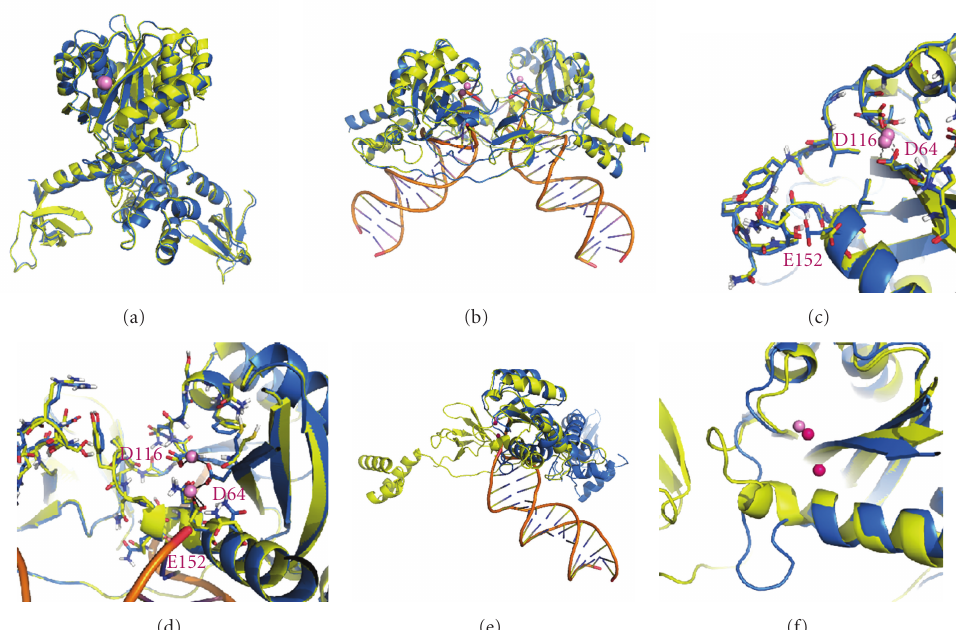
Figure 1: Structural models of the HIV-1 INs from B and CRF02 AG strains. (a) Superimposition of models 1 and 2, representing the enzyme before the 3 (cid:2) processing from B (in blue) and CRF02 AG (in yellow) strains; (b) Superimposition of models 3 and 4, representing the IN · DNA pre-integration complex from B (in blue) and CRF02 AG (in yellow) strains; (c) and (d) Comparison of the catalytic site and loop 140–149 structure in models 1/3 (in blue) and 2/4 (in yellow) respectively. The proteins are shown as cartoons, Mg +2 ions as spheres (in pink). (e and f) superimposition of the structural subunits from models 1 (in blue) and 3 (in yellow) and the structural details of the active site and loop